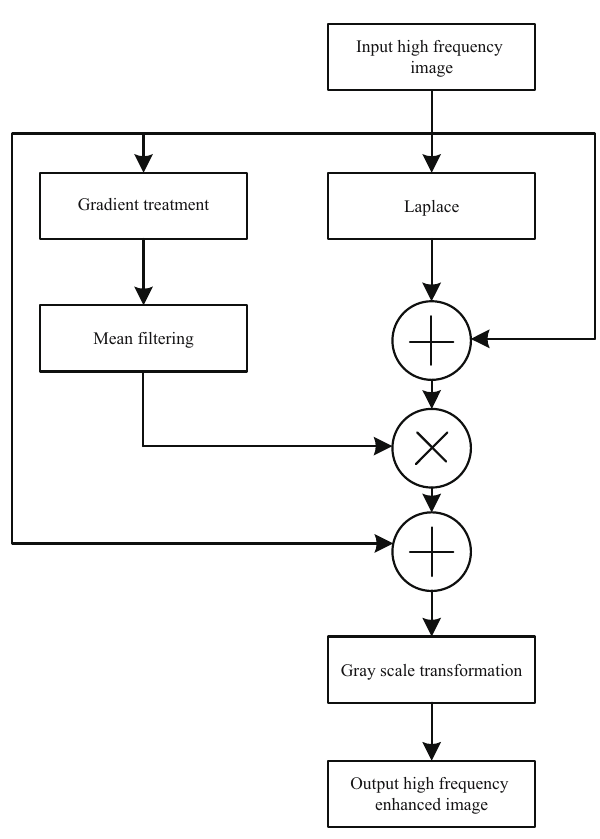
Figure 3: Processing steps of high dynamic image edge detail